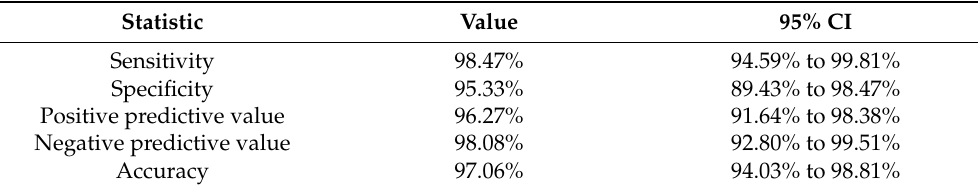
Table 4. Sensitivity, specificity, positive predictive value, negative predictive value, and accuracy of lymph node FNC.